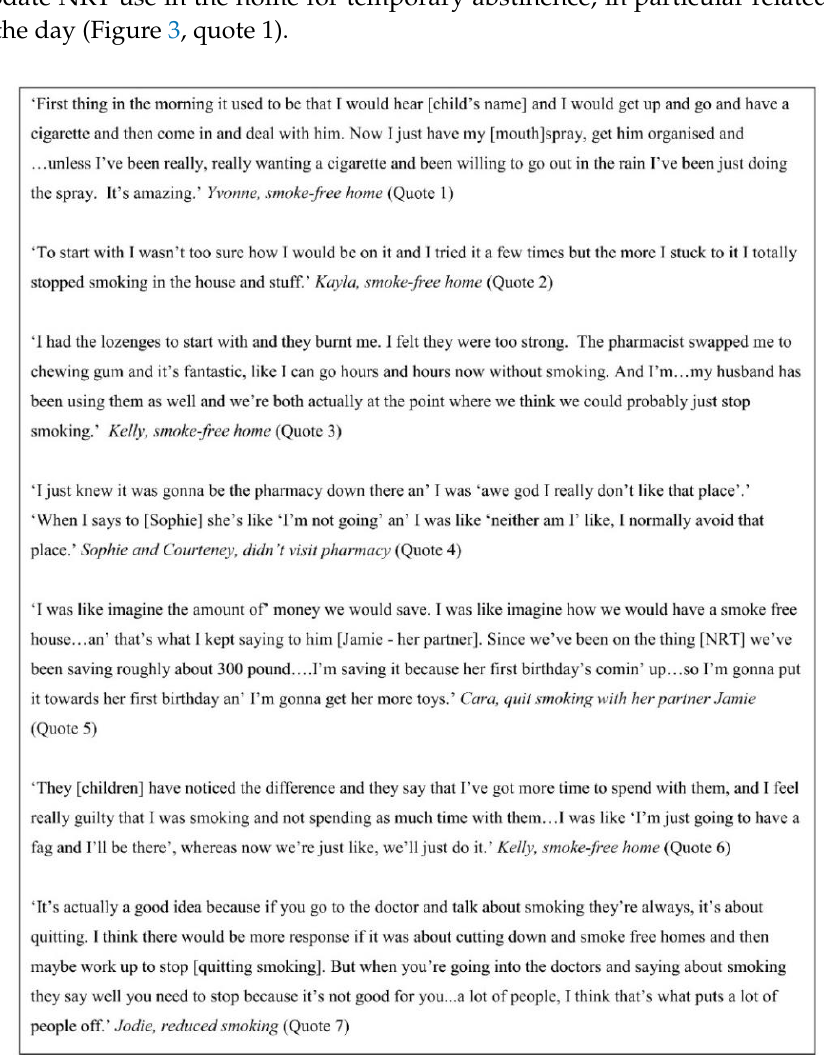
Figure 3. Parents’ experiences of using nicotine replacement therapy (NRT) to create a smoke-free home.